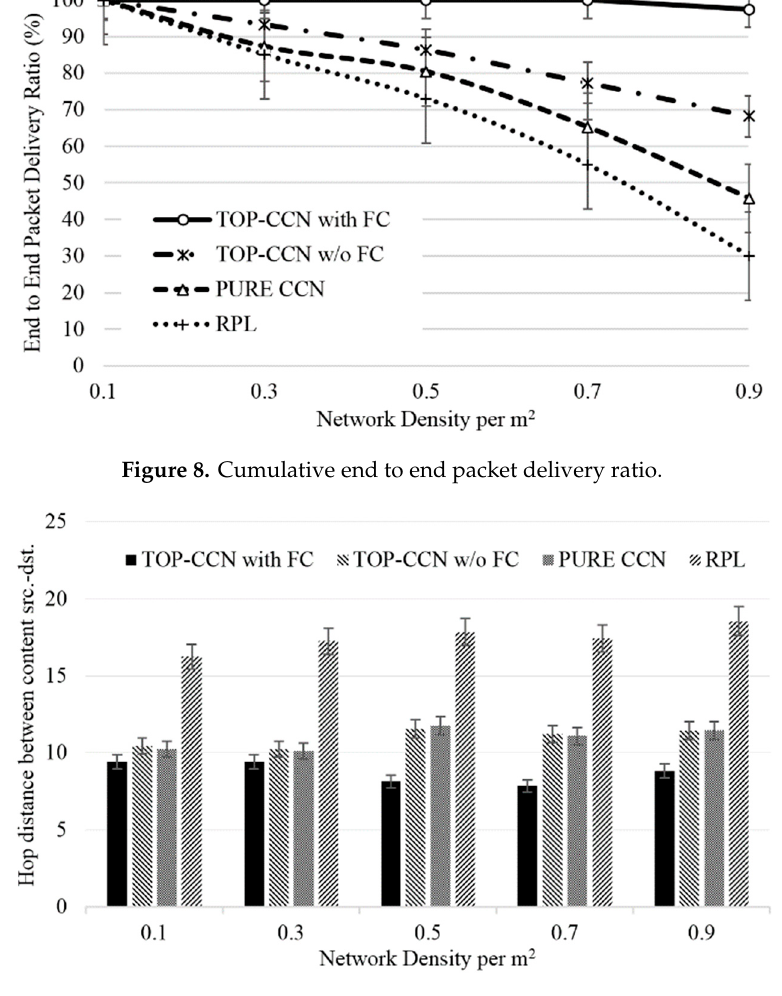
Figure 9. Average hop distance between content location and device.